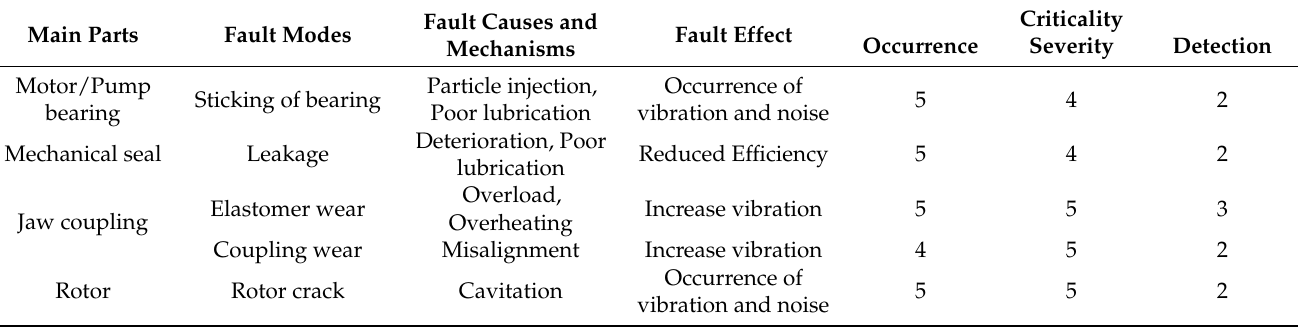
Table 1. Fault modes, effects and criticality analysis (FMECA) for 5 types fault modes of